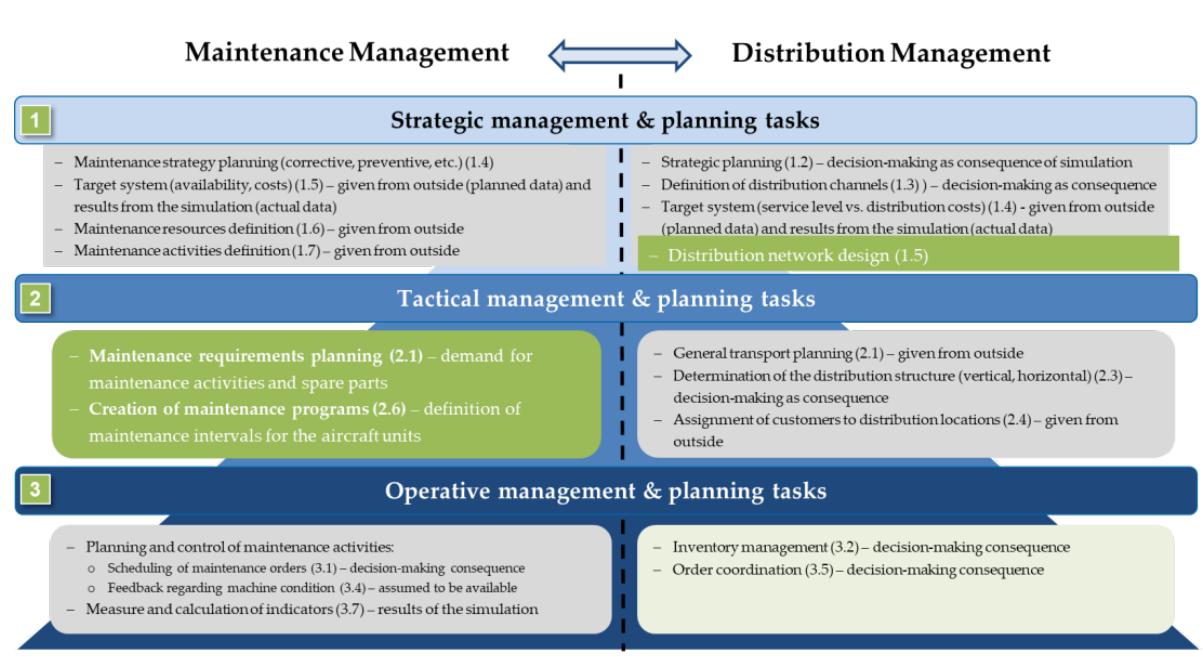
Figure 2. Conceptual model configuration options (in green boxes) based on the management and planning tasks considered (own elaboration).